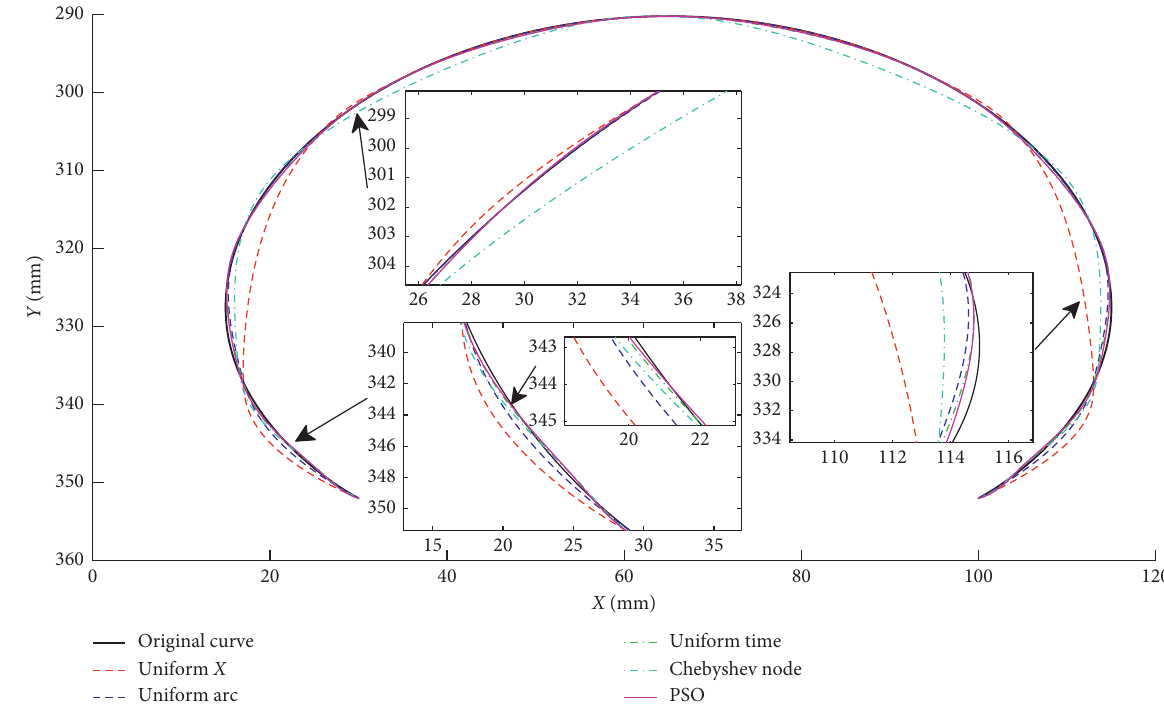
Figure 14: Comparison of different trajectory restoration